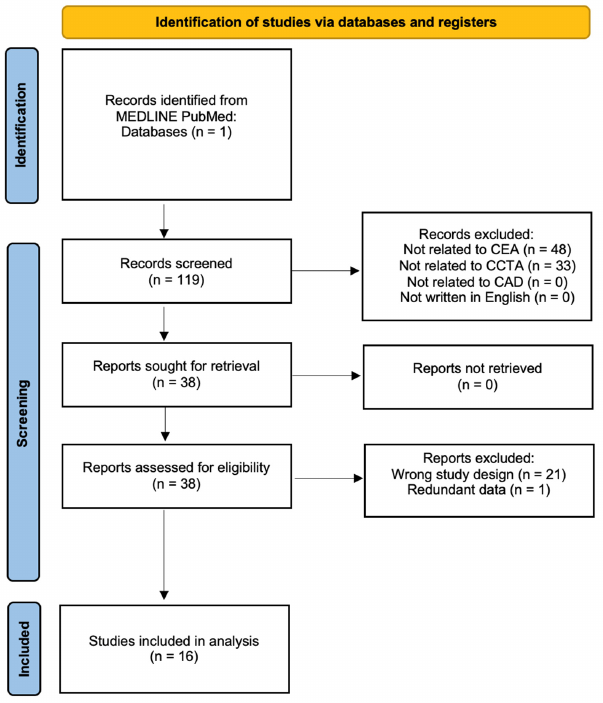
Figure 1. Flow diagram summarizing the identification of included studies.